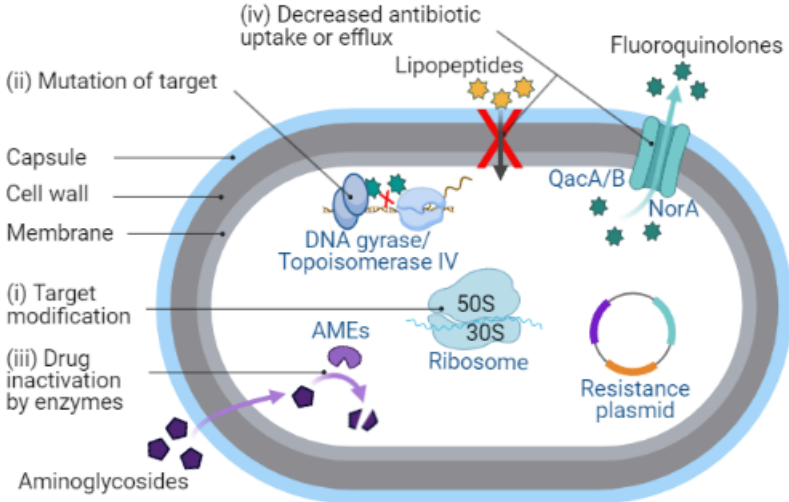
Figure 2. Schematic representation of the mechanisms of antibiotic resistance in S. aureus . (i) Target modification: change in the structure or composition of the target site in a bacterial cell can stop the antibiotic to bind, thus shielding it from the antibiotic. Modification of the bacterial ribosome by 23S ribosomal RNA ( rRNA ) methyltransferase (encoded by erm genes) leads to a conformational change in the ribosome target [31,32], thereby preventing the binding of erythromycin to the ribosomal target. (ii) Mutation of target: mutations in the target can prevent the antibiotic from binding, or if it binds, preventing it from inhibiting the target. Mutation in the DNA topoisomerase IV subunit A (encoded by grlA gene) and an essential enzyme DNA gyrase subunit A (encoded by gyrA gene) is the main contributor to fluoroquinolone resistance in S. aureus [33–35]. (iii) Drug inactivation by enzymes: several S. aureus enzymes modify the structure of antibiotics or break them down to make them inactive. The bifunctional aminoglycoside-modifying enzyme (AME) AAC(6 (cid:48) )/APH(2”) (encoded by aac(6 (cid:48) )/aph(2 ”) genes) confers resistance to aminoglycosides via acetyltransferase and phosphotransferase activities [36,37]. (iv) Decreased antibiotic uptake or efflux: decrease in the permeability of cell membrane to drugs makes it more difficult to pass through or activation of an efflux pump that removes antibiotics from the bacterial cell. The norA, qacA / B, and smr ( qacC/D ) genes encoding multidrug efflux pump proteins are found mainly in S. aureus clinical isolates and mediate resistance to fluoroquinolones, tetracyclines, and reduced susceptibility to certain antiseptics